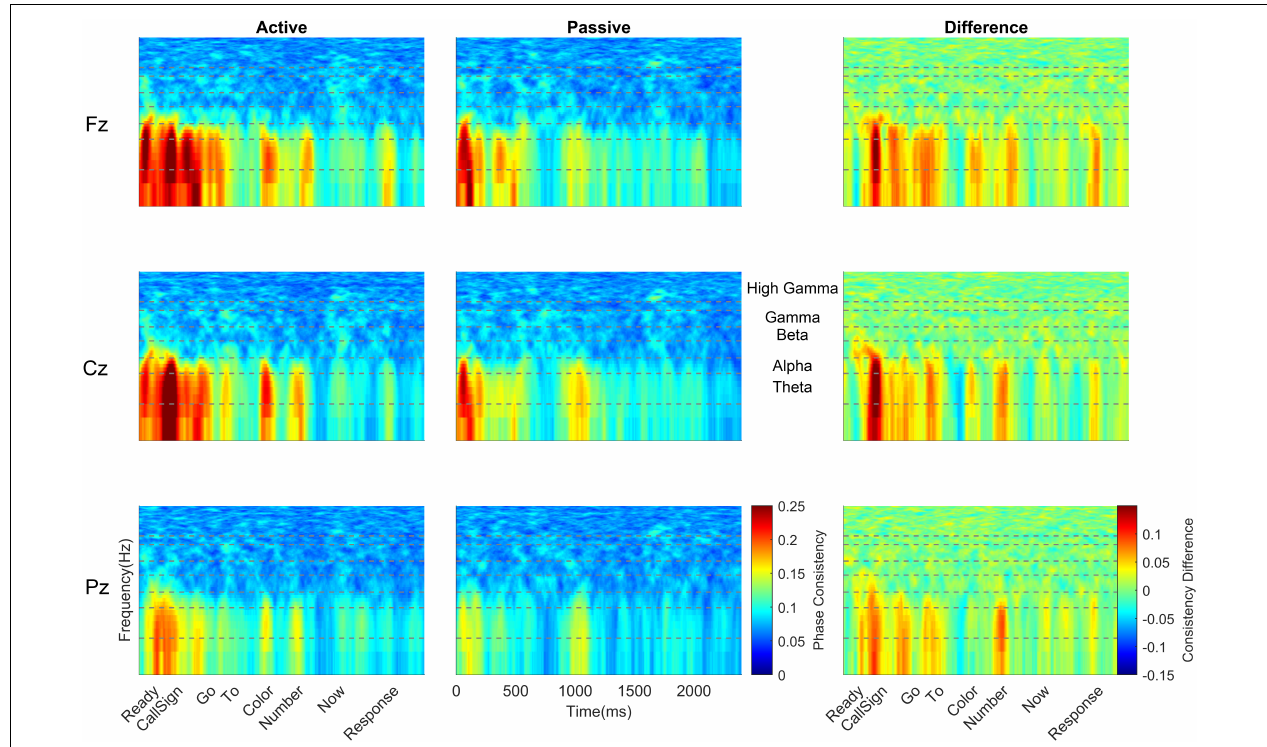
FIGURE 3 | Monolingual cortical phase consistency. Monolingual phase consistency is plotted at Fz (top) , Cz (middle) , and Pz (bottom) for active (left) and passive (center) listening conditions. For these six plots, color represents greater phase consistency, with warmer colors indicating greater consistency and cooler colors representing little to no consistency. The rightmost plots show the difference in phase consistency between active and passive listening conditions, with warmer colors indicating greater consistency during active listening and cooler colors indicating more consistency during passive listening. Monolinguals showed the most cortical consistency during active listening (left column), with the beginning of the sentence showing the highest consistency that declined as the sentence unfolded. This effect was varied across the scalp, being greatest at Fz and lowest at Pz. Active and difference plots align the cortical consistency with the words in the sentence and passive plots provide an indication of time. Dashed lines on all plots identify the borders of the frequency bands, which are labeled between the passive and difference plots for Cz. To visualize the lower frequencies, all y -axes are plotted on a log